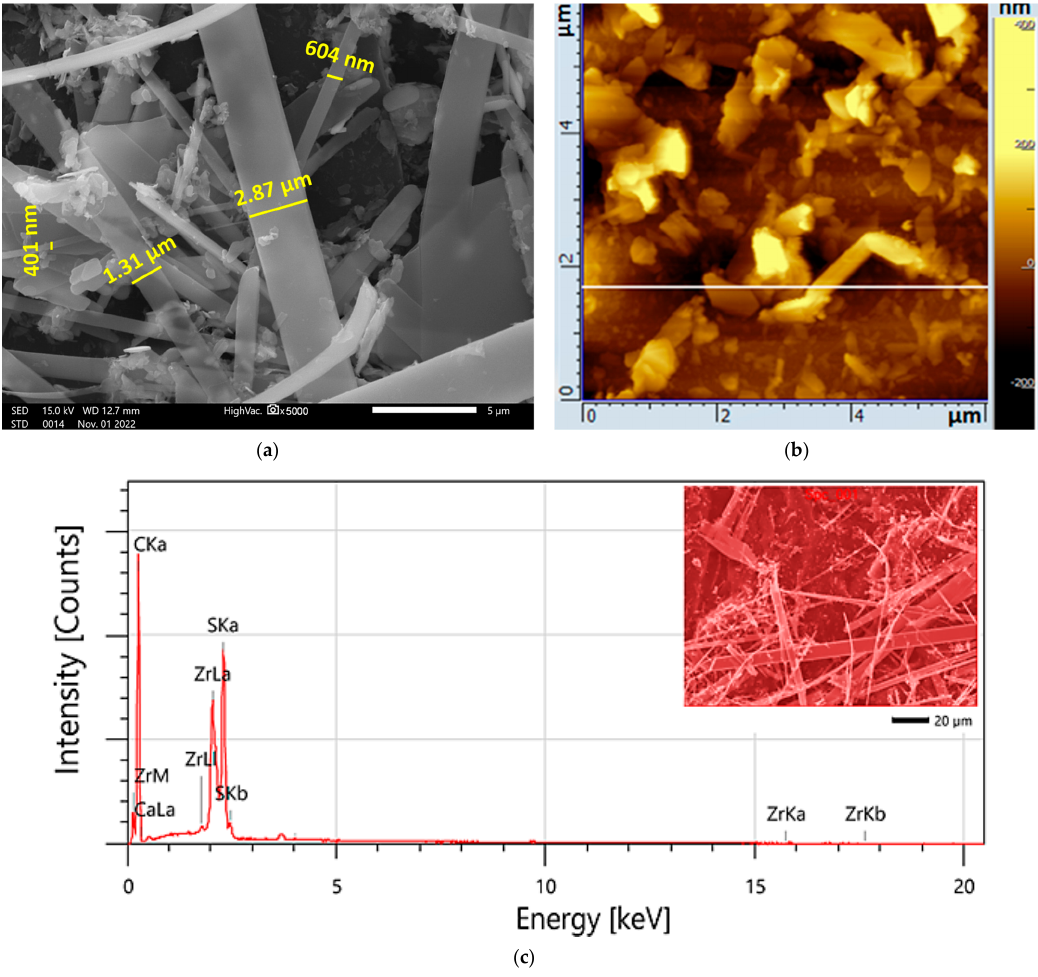
Figure 3. Analyses of ZrS 3 : ( a ) SEM image; ( b ) AFM image; ( c ) elemental composition (EDX). Figure 4a,b show microphotography of films consisting of the ZrS 3 and GO mix. The microphotographs show GO film covering ZrS 3 nanocrystals.